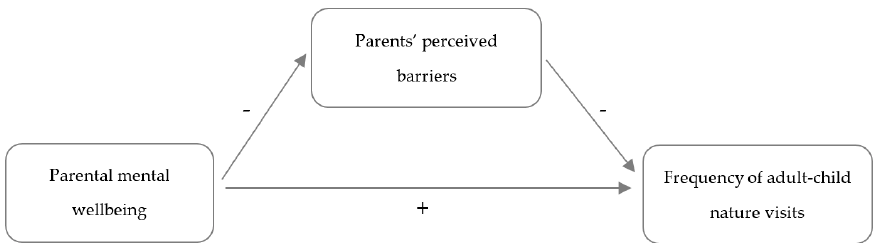
Figure 1. Hypothesized mediation model explaining associations between parental mental well- being, parents’ perceived barriers (mediator) and frequency of adult-child nature visits.